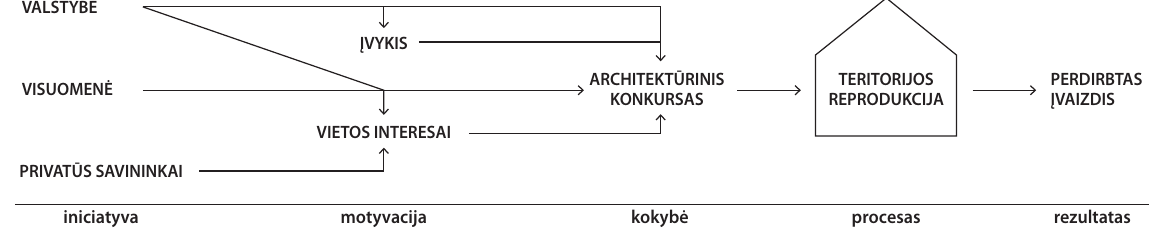
fig. 2. algorithm of conversion